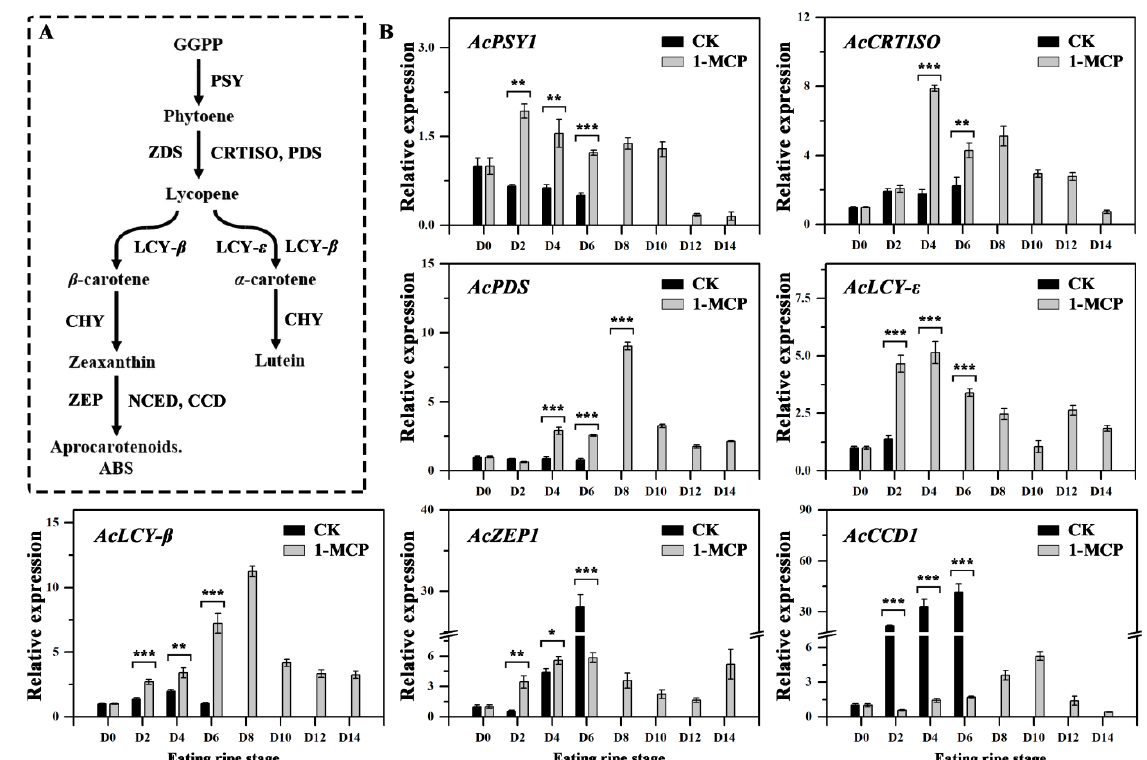
Figure 3. Expression profiles of genes involved in the carotenoid pathway in the flesh of kiwifruit. ( A ) Carotenoid biosynthetic and degradation pathways in kiwifruit. ( B ) Effect of 1-MCP on the expression profiles of carotenoid pathway related genes in the flesh during storage. The D0 stage was used as the reference (=1 relative expression) for each gene. Error bars show SE of the mean. Data were analyzed with Student’s t -test (* P < 0.05, ** P < 0.01, *** P < 0.001).